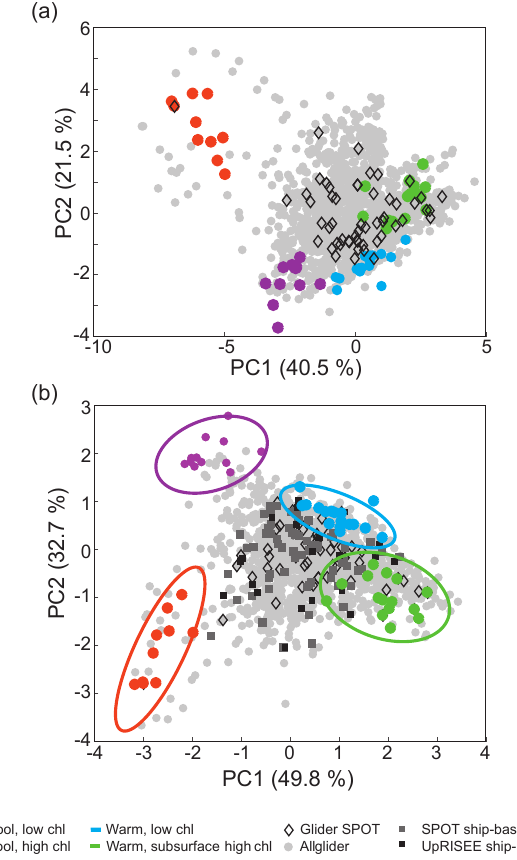
Figure 3. Principal component analysis of glider profiles. The orig- inal PCA (a) and structured PCA (b) are shown. The four end- member water column profile types used to create the structured principal component axes are indicated on both plots. All glider pro- files collected in 2013 and 2014 are also shown (grey dots). Glider profiles from the SPOT location are shown as black diamonds and compared against ship-based profiles (grey and black squares).